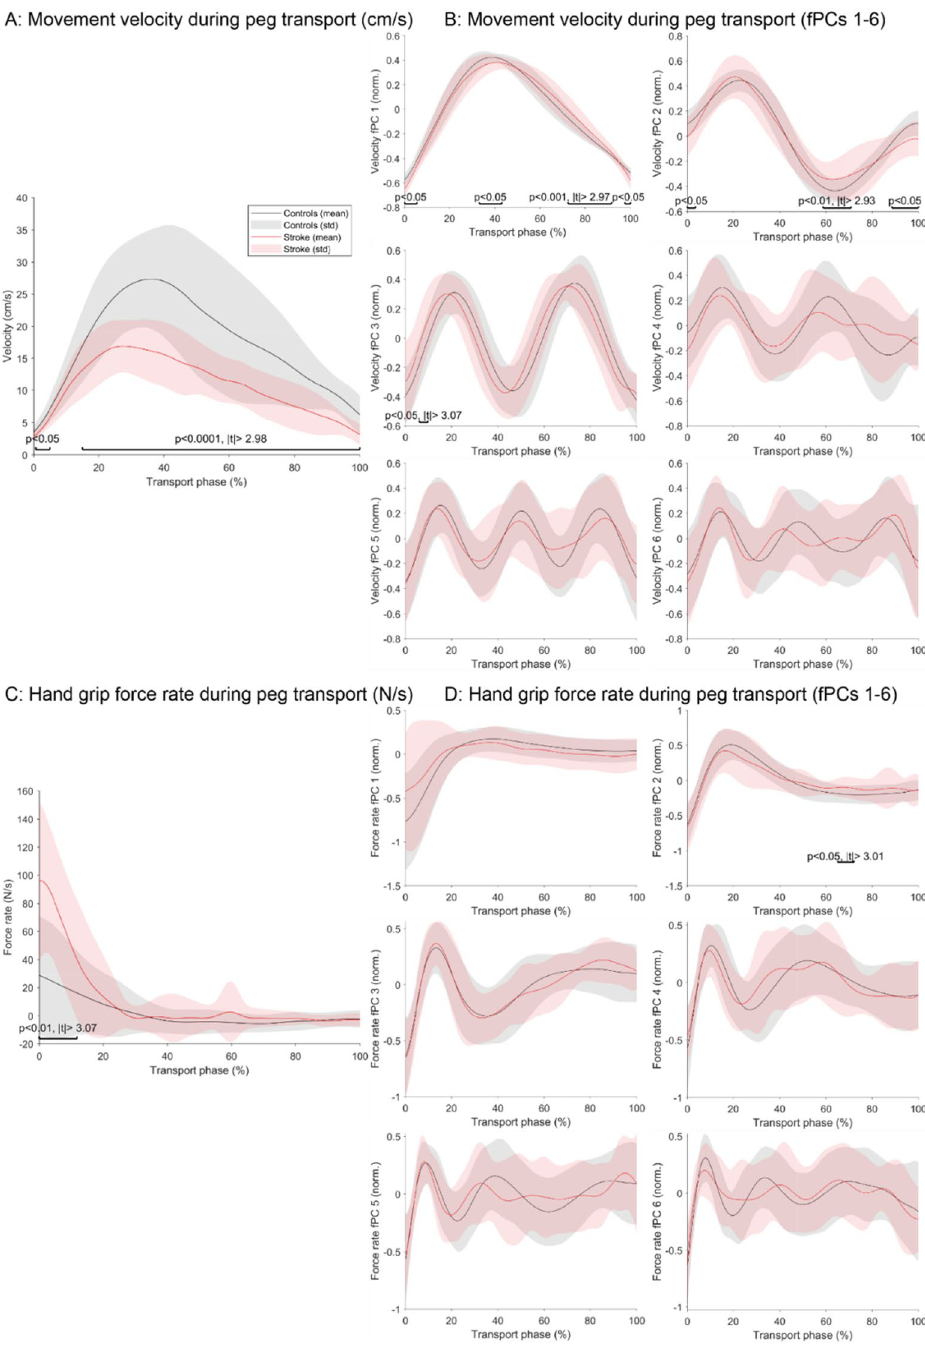
Figure 2. Movement and hand grip force coordination during the transport phase of the functional task. The preprocessed end-effector velocity ( A ) and grip force rate ( C ) signals were visualized for the paretic side of post-stroke subjects (red) and a healthy age-matched control population (gray). In addition, the shapes of the fPCs for the velocity ( B ) and the force rate ( D ) signals were visualized. The time-series of the stroke and control population were compared using statistical parametric mapping and the p- and t-values of significant periods